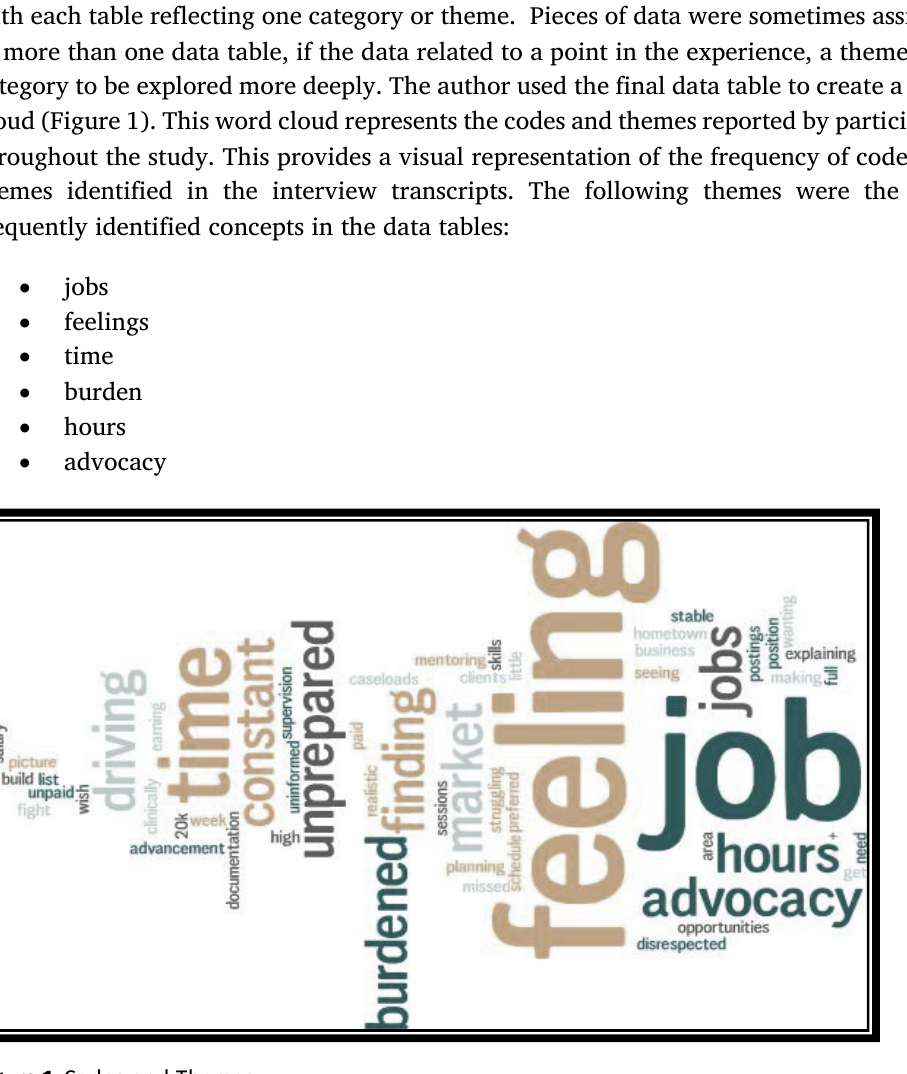
Figure 1. Codes and